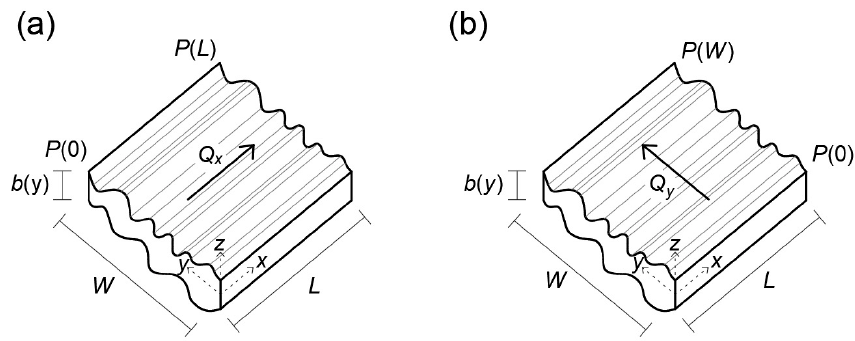
Figure 3. Conceptual model representation: (a) parallel arrangement and (b) serial arrangement.